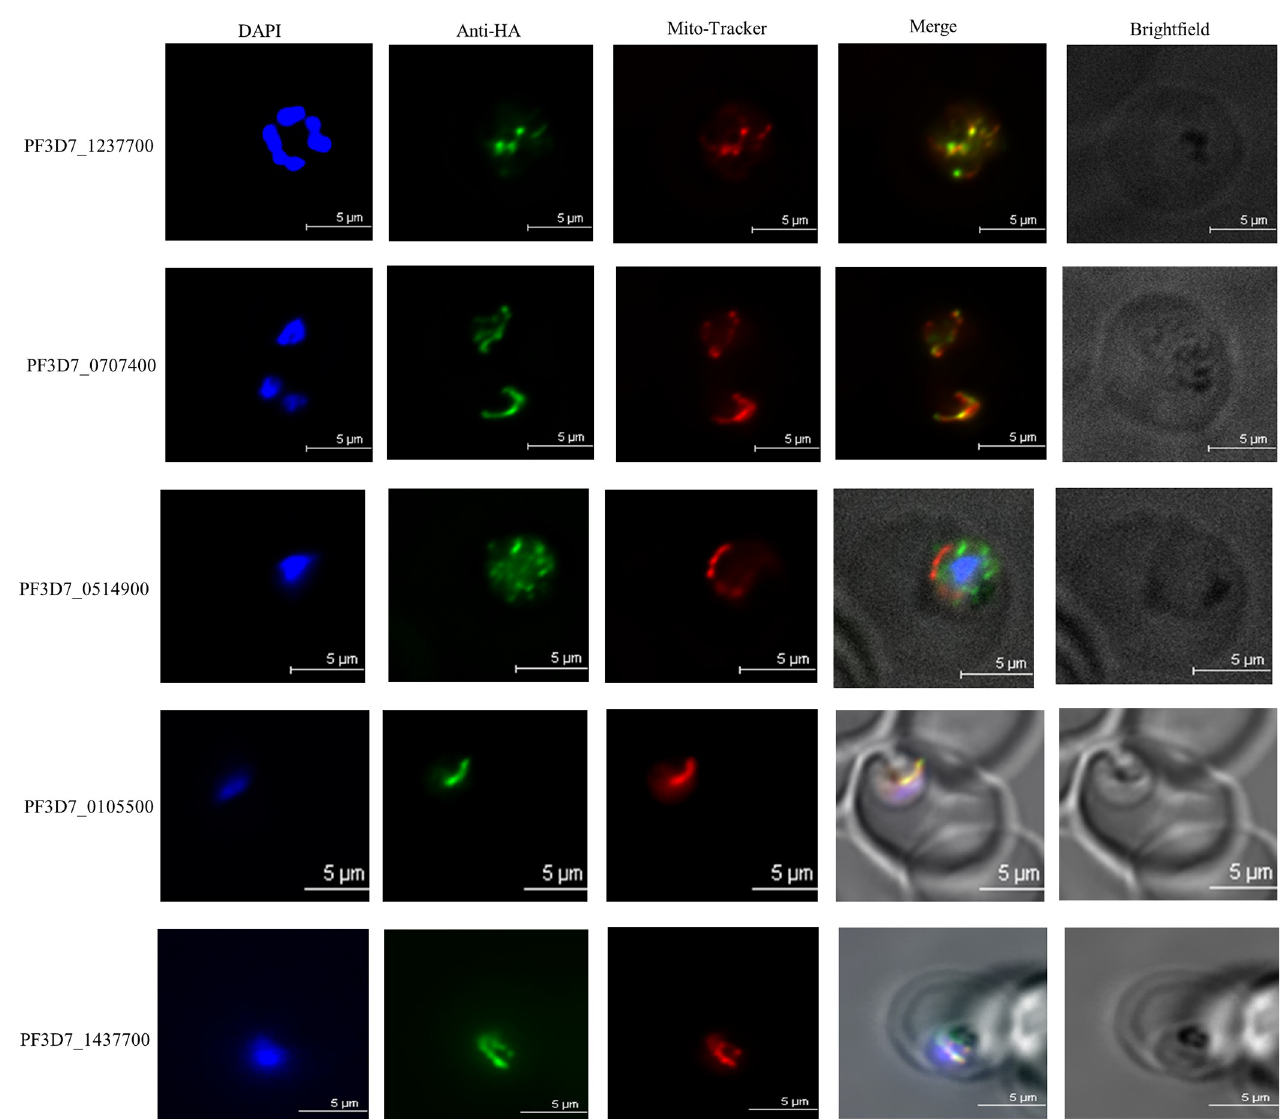
Fig 6. Localization of proteins identified by proximity biotinylation. Immunofluorescence assays were conducted to observe the localization of selected putative mitochondrial proteins. Live parasites were stained with Mito-Tracker (red). Parasites were then fixed and stained with DAPI (blue) and anti-HA antibody (green). Images are representative of ~20 captured images. Scale bars denote 5 μ